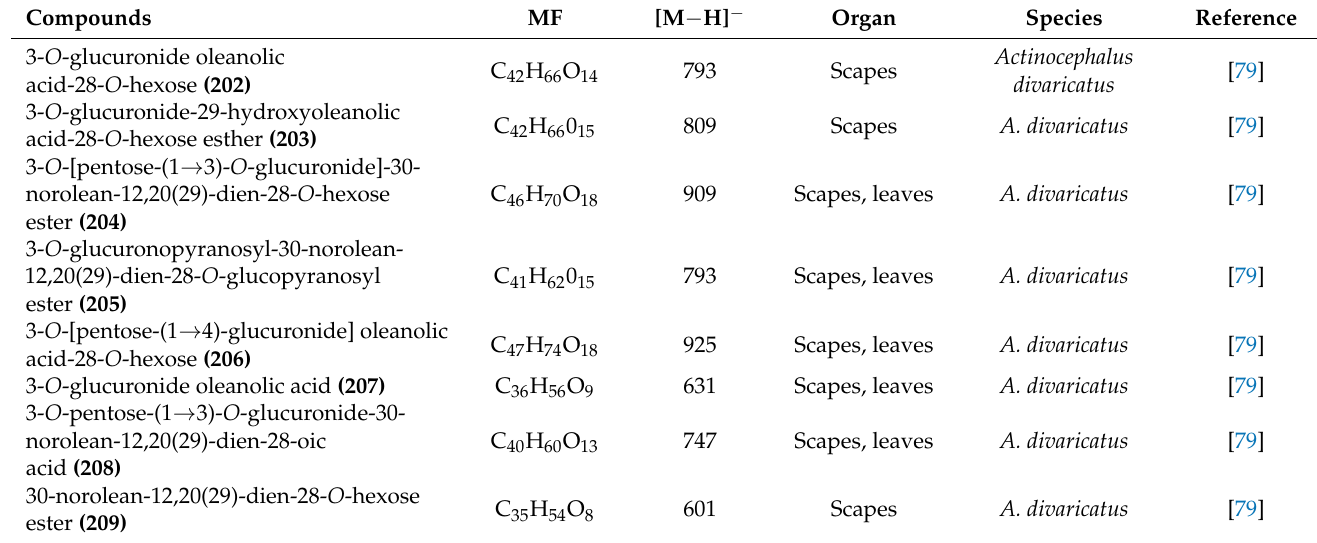
Table 5. Saponins isolated from Eriocaulaceae species.